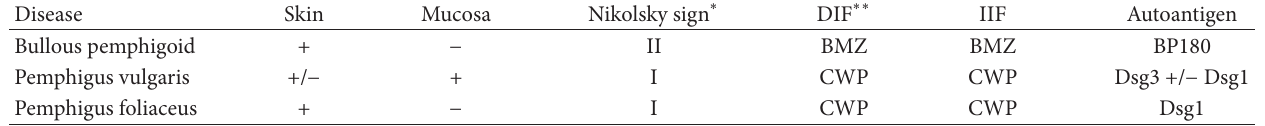
T 1: Clinical and laboratory characteristics of bullous skin